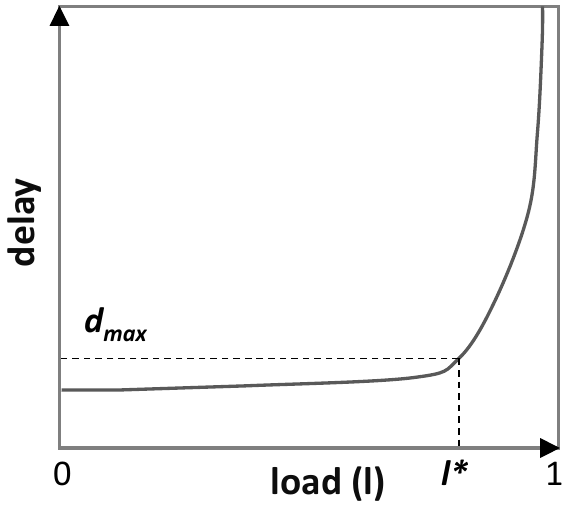
Figure 4. Delay model example.